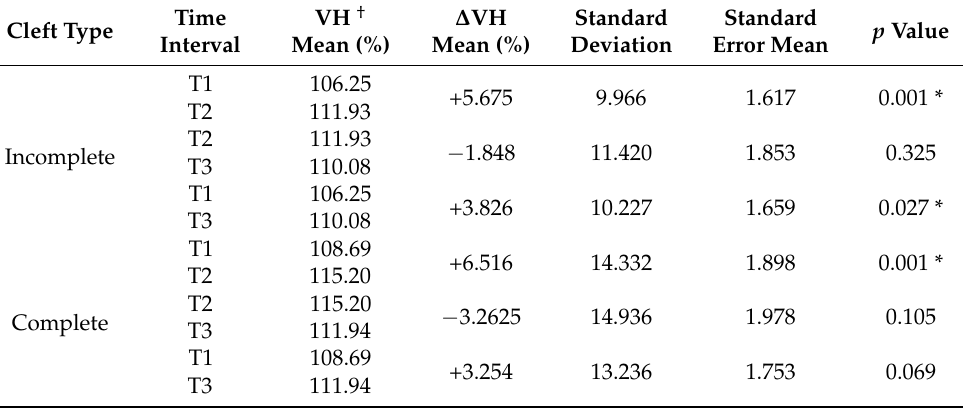
Table 2. Changes in vermillion height at T1, T2, and T3.